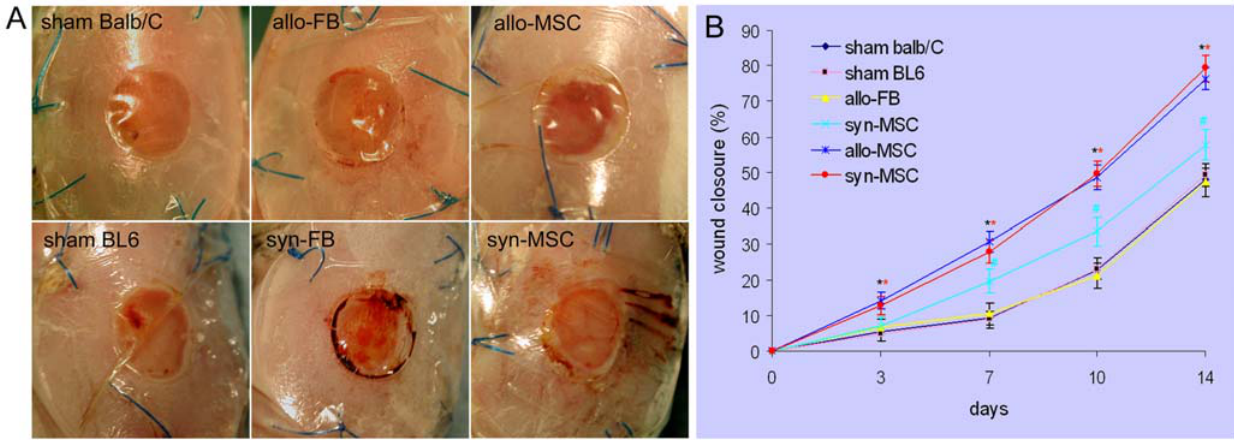
Figure 2. Effects of BM-MSCs on wound closure. (A) Excisional wounds in allogeneic (allo-) Balb/C or syngeneic (syn-) C57BL/6 mice received implantation of C57BL/6 derived GFP + BM-MSCs (MSC), dermal fibroblasts (FB) or control vehicle medium (sham). Representative photographs of wounds at day 7 (with transparent Tegaderm dressing) are shown. Within the splint, the red area represents the unhealed area and the surrounding white area indicates the newly grown tissue from the wound edge. (B) Measurement of wounds (at day 3 and 7, n=12 to 14; at day 10 and 14, n=6 or 7). ANOVA, vs sham * P , 0.01, # P , 0.05.